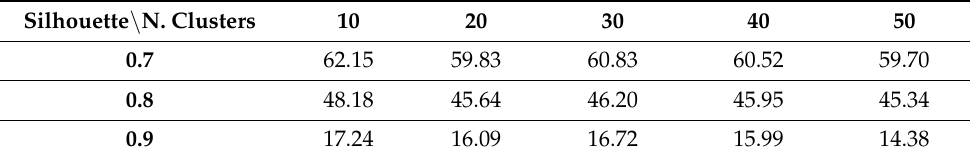
Table 37. Clustering performance in terms of silhouettes using original data. Silhouette \ N. Clusters